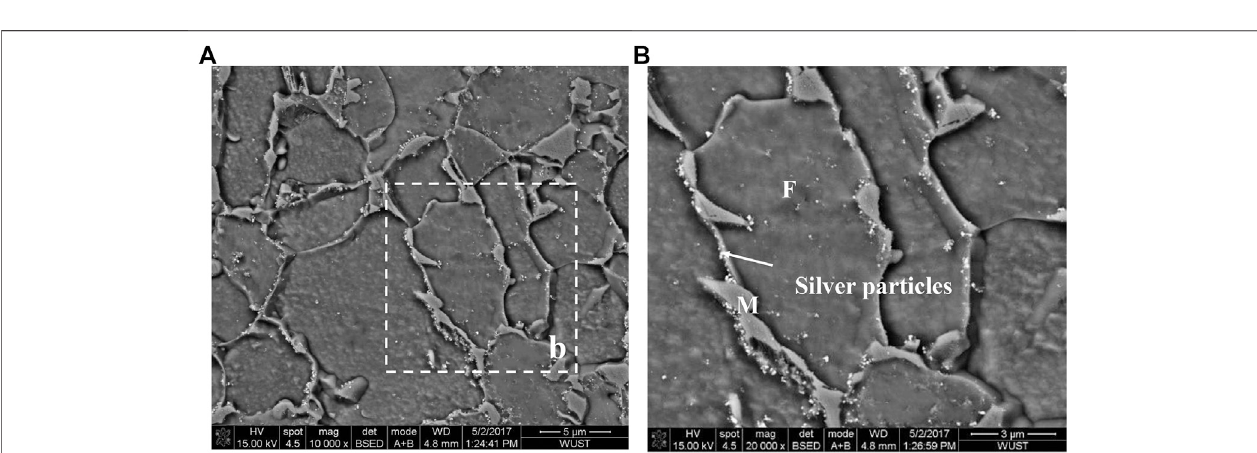
FIGURE 7 | Hydrogen-induced cracks of DP steels with different martensite content: (A) 18.5%; and (B) 46.7%.